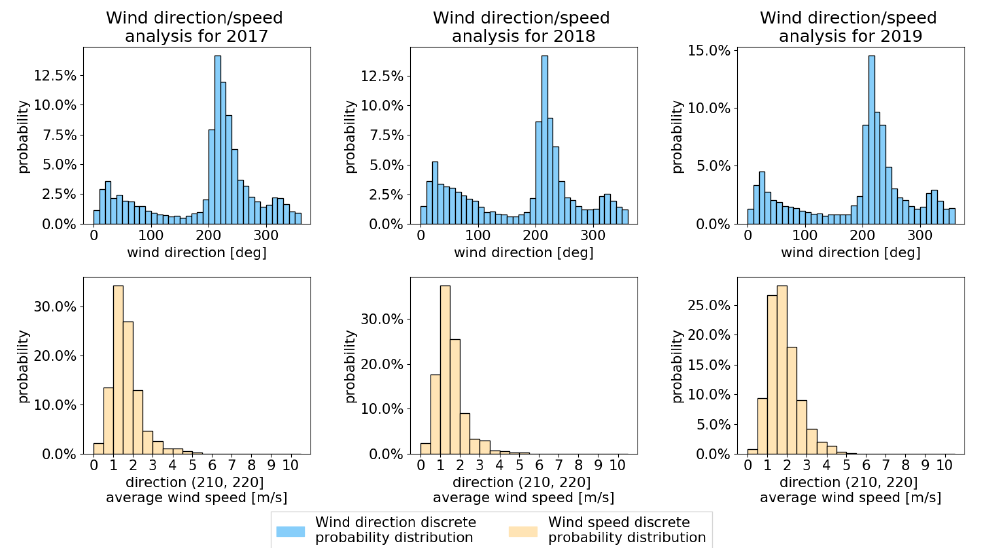
Figure 7. Annual wind direction and wind speed (for SW direction) probabilities for the years 2017–2019 in the Stöckach